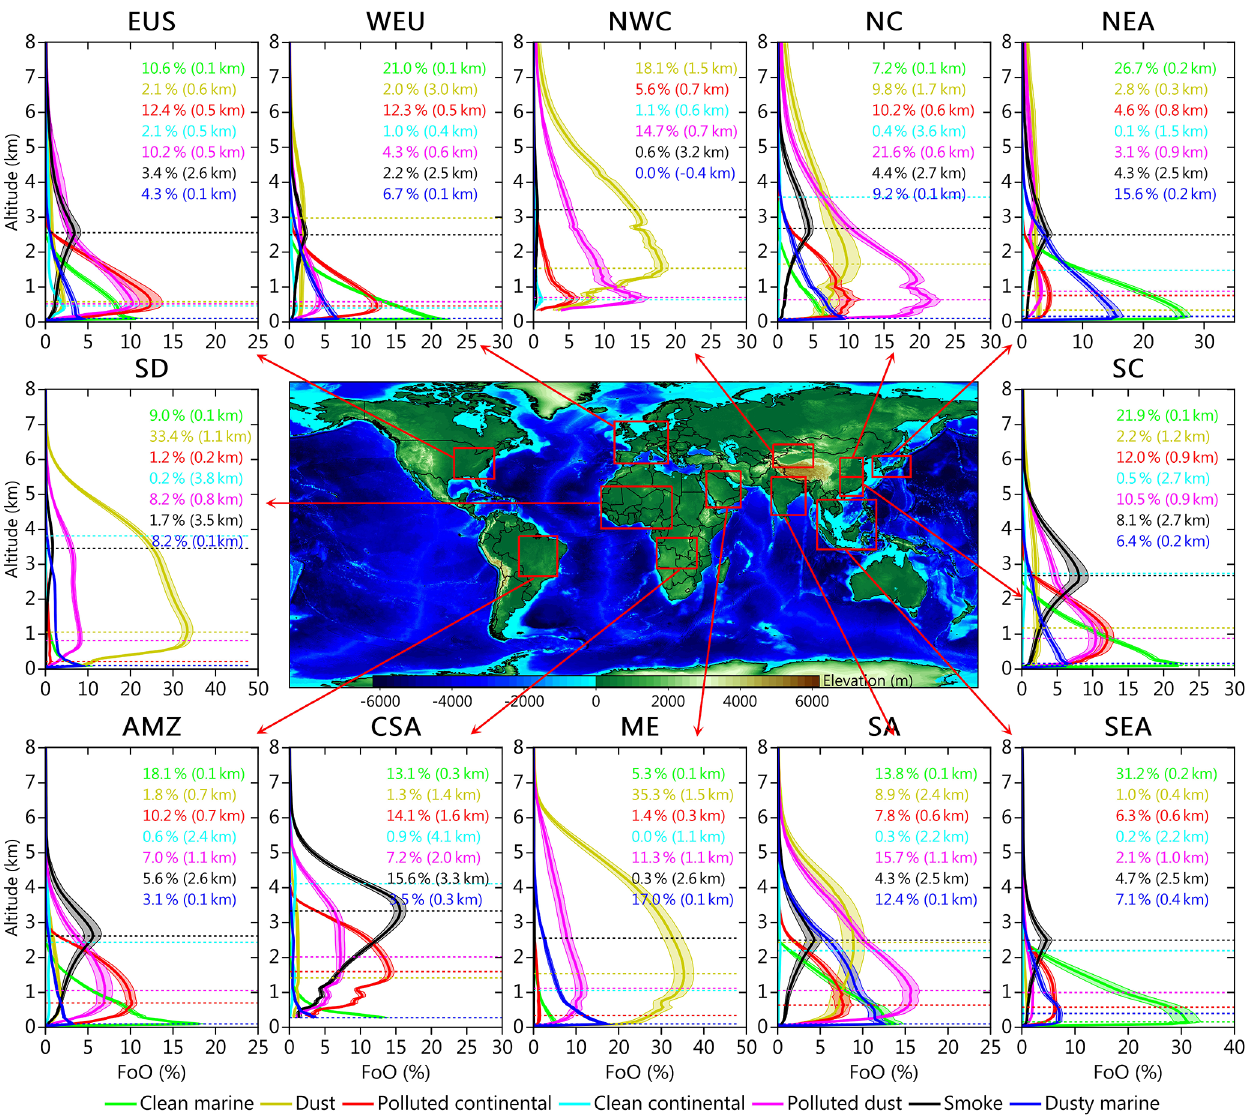
Figure 12. Regional-averaged vertical profiles of multi-year average FoO for type-dependent aerosols over the 12 ROIs. The shading in each subpanel represents the multi-year average standard deviation. Note that the altitudes corresponding to the maximum FoO for different types of aerosols are also indicated in each